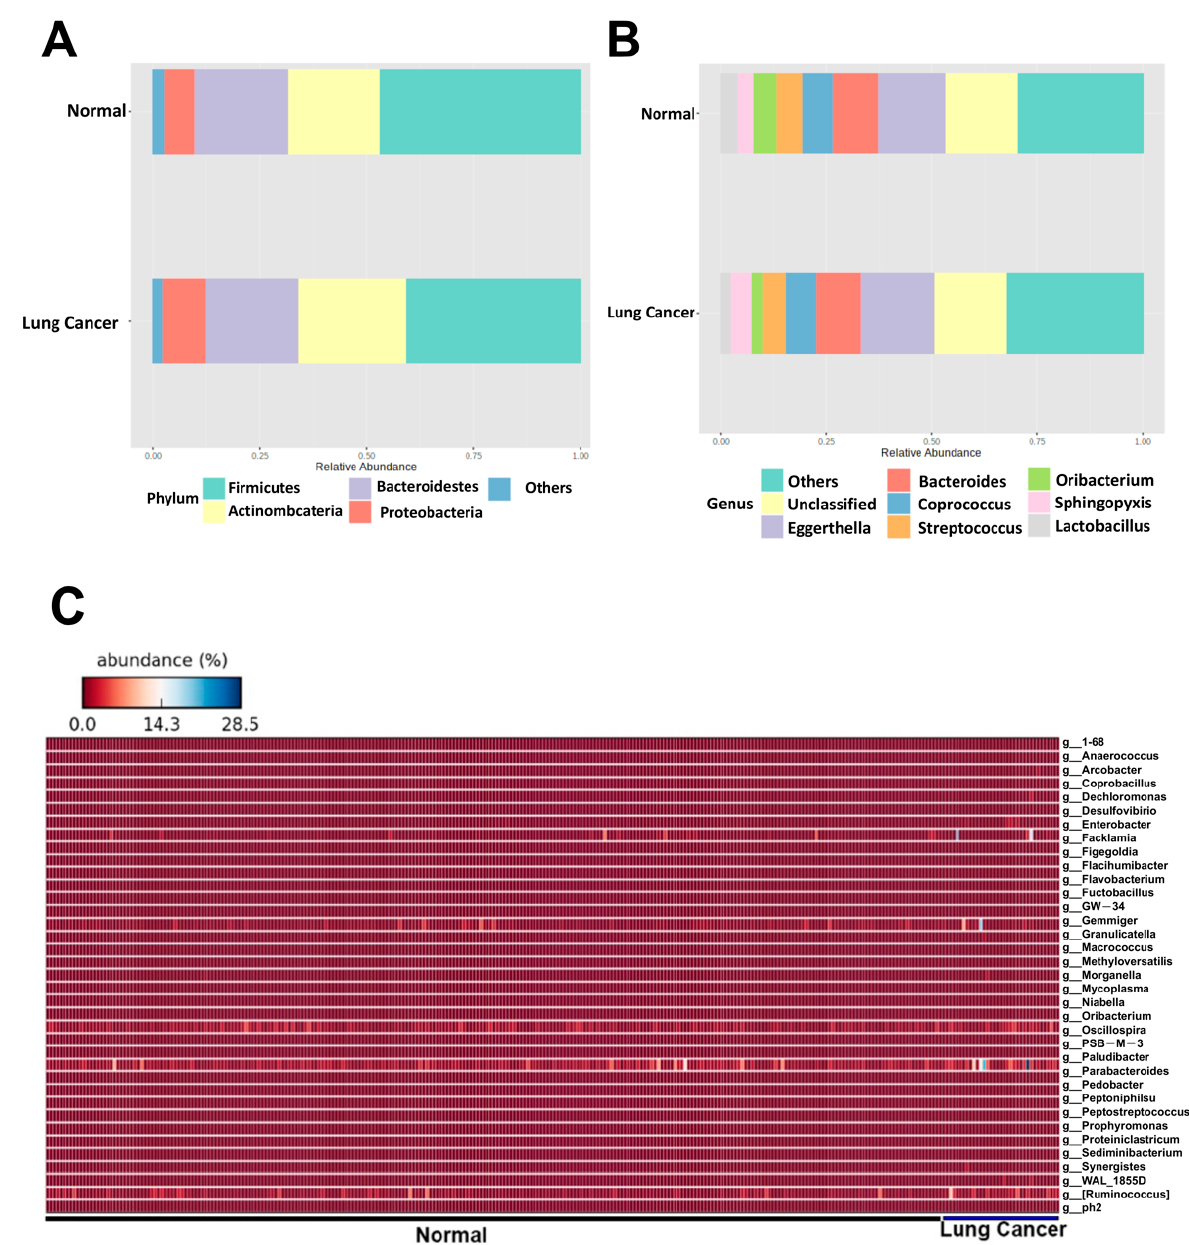
Figure 2. The top 10 most abundant gut microbes in patients with NSCLC are illustrated at phylum ( A ) and genus ( B ) levels. Heatmap analysis of the species level ( C ) of the gut microbes between groups.